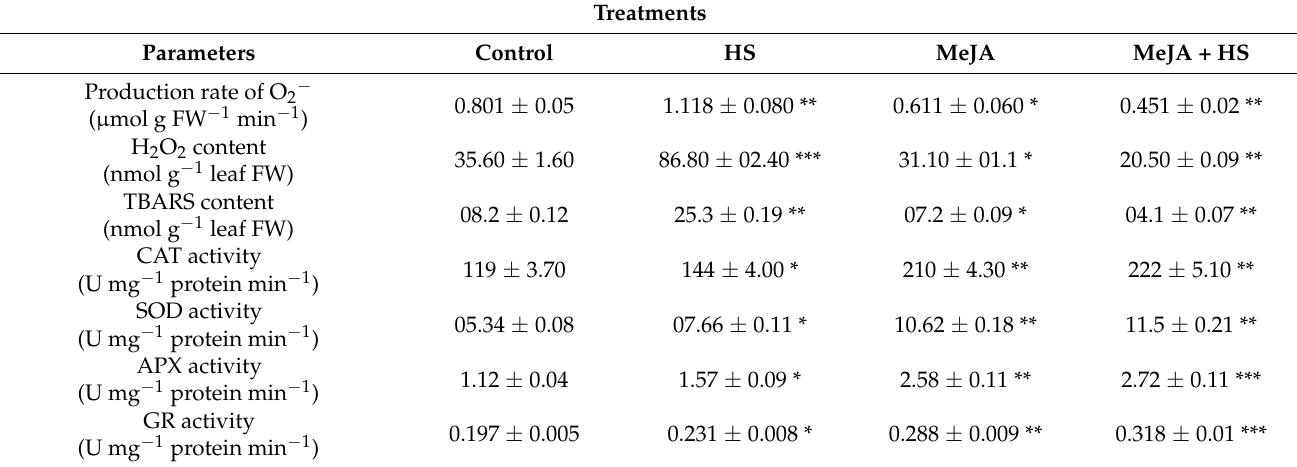
Table 3. Production rate of superoxide radicals (O 2 − ), content of H 2 O 2 , TBARS, activity of CAT, SOD, APX, and GR in wheat leaves at 30 DAS. Plants were treated with MeJA (10 µ M) at 42 ◦ C (heat stress) or 25 ◦ C (no stress). Data are presented as mean ± SE ( n = 4). Significantly different values between control and treatments are marked with an asterisk (* p < 0.05, ** p < 0.01, *** p < 0.001), as determined by Tukey’s test. APX, ascorbate peroxidase; CAT, catalase; DAS, days after sowing; FW, fresh weight; GR, glutathione reductase; HS, heat stress; H 2 O 2 , hydrogen peroxide; MeJA, methyl jasmonate; SOD, superoxide dismutase; TBARS, thiobarbituric acid reactive